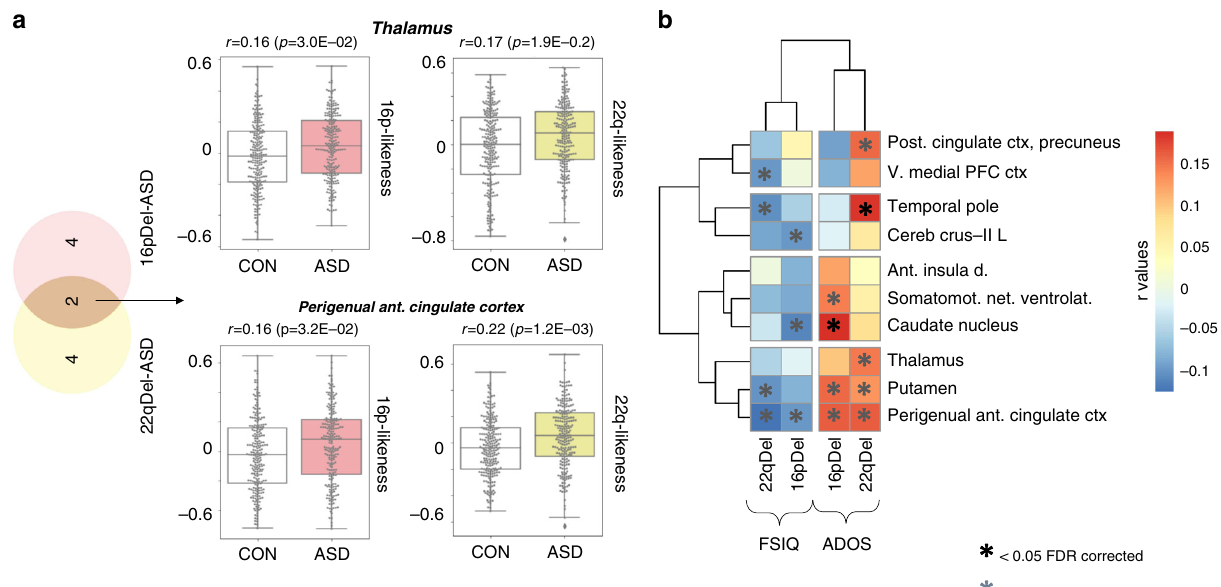
Fig. 5 Relationship between the deletion FC-signatures and behavior. a Boxplots represent the connectivity similarity for two seed regions (thalamus and perigenual anterior cingulate cortex). Boxplots display the 25th, 50th, and 75th percentile of the underlying data. Boxplot whiskers encompass data points within 1.5 times the interquartile range from the median line and more extreme data points are labeled with outlier fl iers. Each data point represents one individual: r -value of the Pearson correlation between the deletion FC-signatures and the FC-pro fi le of an individual with ASD ( n = 225 in the colored boxplots) or a control subject ( n = 234 in the non-colored boxplots). For the two seed regions, individuals with ASD show signi fi cantly higher similarity (FDR, q < 0.05) with the 16p11.2 (pink) and 22q11.2 (yellow) deletion FC-signatures than the individual controls. All seed regions showing signi fi cantly higher similarity with ASD are represented in the Venn diagram on the left. b We investigated the relationship with cognitive scores and found that stronger individual similarity (Pearson ’ s r ) with the deletion FC-signature was associated with more severe symptoms measured by FSIQ and ADOS. Heatmaps show the level of correlation (FDR, q < 0.05, two-sided) between behavior scores and the similarity with deletion FC-signatures. 16pDel 16p11.2 deletion, 22qDel 22q11.2 deletion, FSIQ full-scale intelligence quotient, ADOS autism diagnostic observation schedule, ant. anterior, post posterior, v. ventral, PFC prefrontal cortex, cereb cerebellum, d. dorsal, L left, ctx cortex, net. network. Full-name labels are provided in Supplementary Data